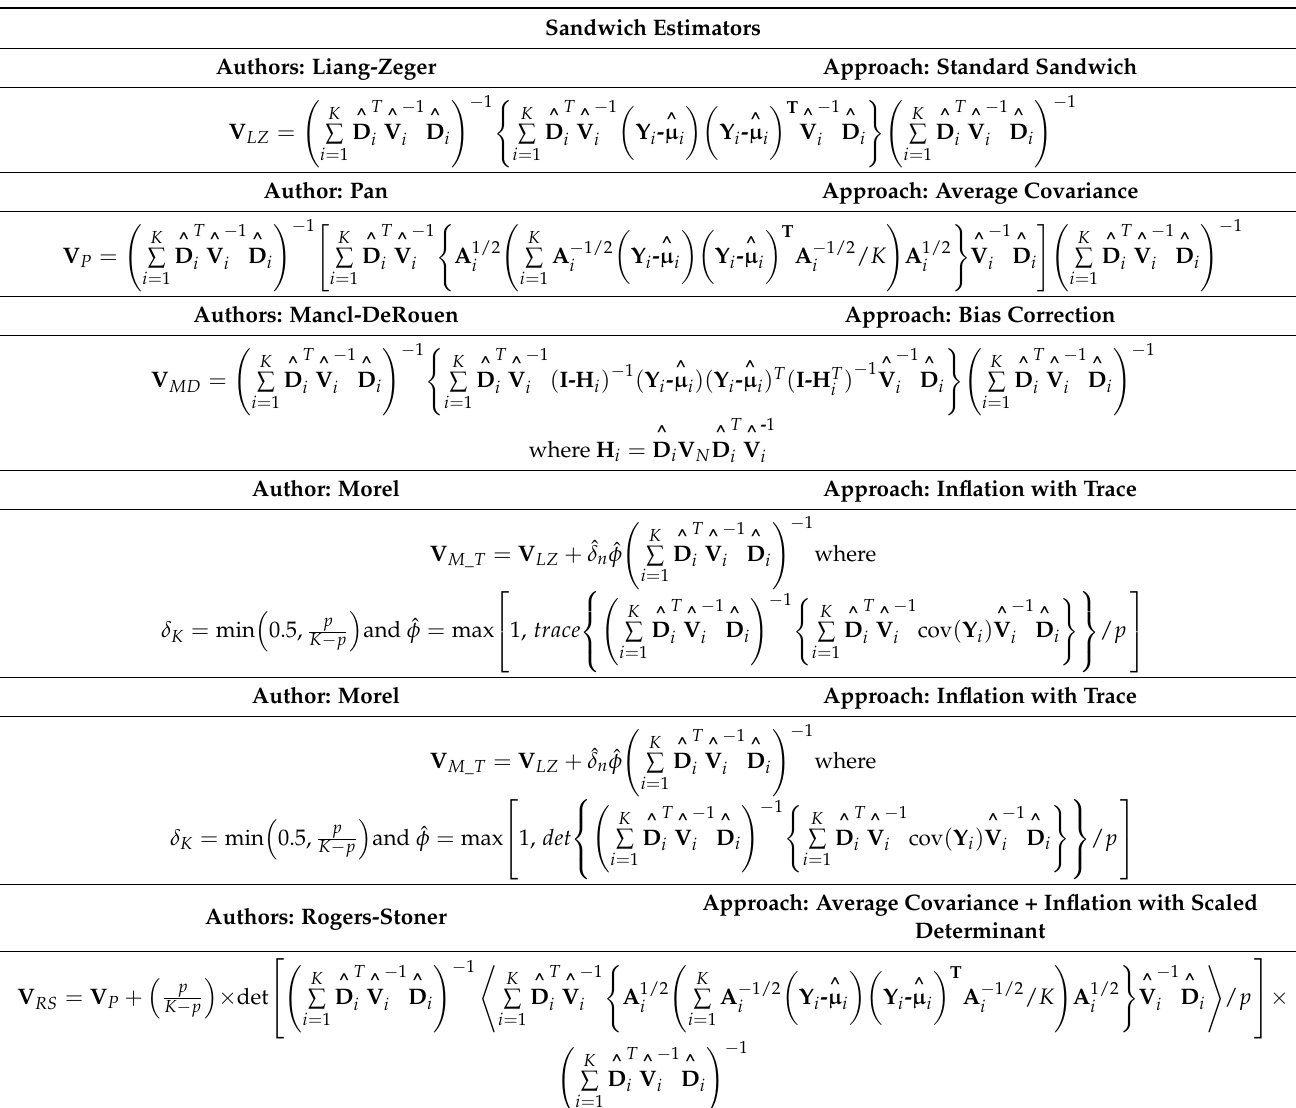
Table 1. The sandwich estimators in vector-matrix notation listed with approach and authors. Sandwich